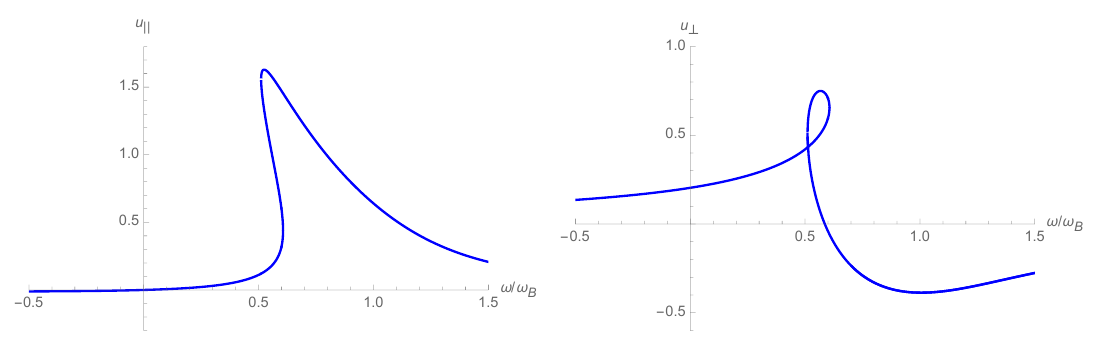
Figure 1 . The pro(cid:12)le for u as a function ! when B = 1, ! B = (cid:26)B= ( (cid:15) + p ), (cid:27) Q = 0 : 25 and (cid:26) = 1. k We can see that the transition from one solution to three solutions occurs when u 0 ( ! ) = (cid:6)1 . k For example, the top right (cid:12)gure is the (cid:13)uid (cid:13)ow with a value of the external (cid:12)eld E given by the bottom most dashed lines. The red lines are where the (cid:13)uid (cid:13)ow becomes unstable. These correspond to (cid:13)ows in the neighborhood of the boundary of the graph. We stress that this is not a true phase diagram in the sense that there are no thermodynamic phase transitions as one tunes the parameters. Instead, these phases are characterized by distinct behavior of the Hall conductivity as a function of the driving frequency. In the shaded region, the Hall conductivity increases with the driving, while it decreases in the unshaded